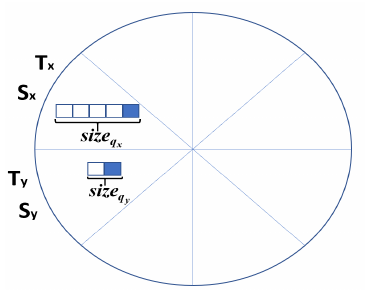
Figure 8. Adaptive beamforming time RR-MAC